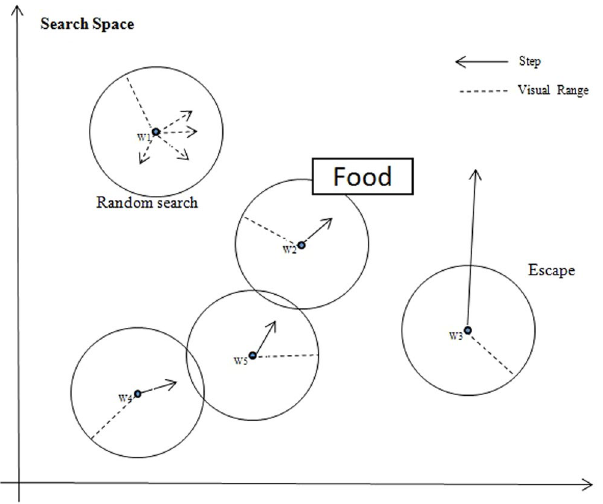
Figure 6. Hunting behaviors of WSA (based on an example of a population of five wolves in